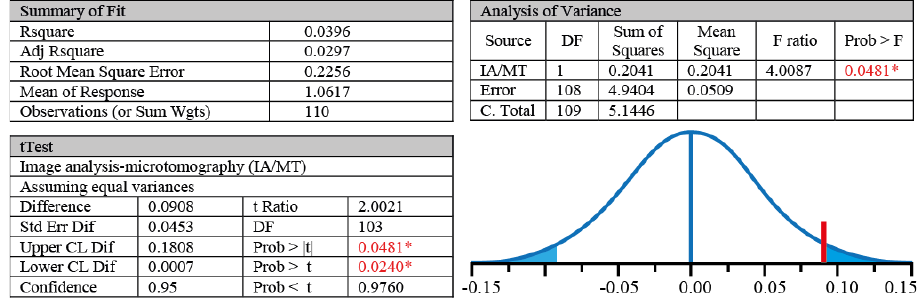
Figure 5. Results of statistical comparison of evaluated methods. Table 3. Summarized results of descriptive statistics.